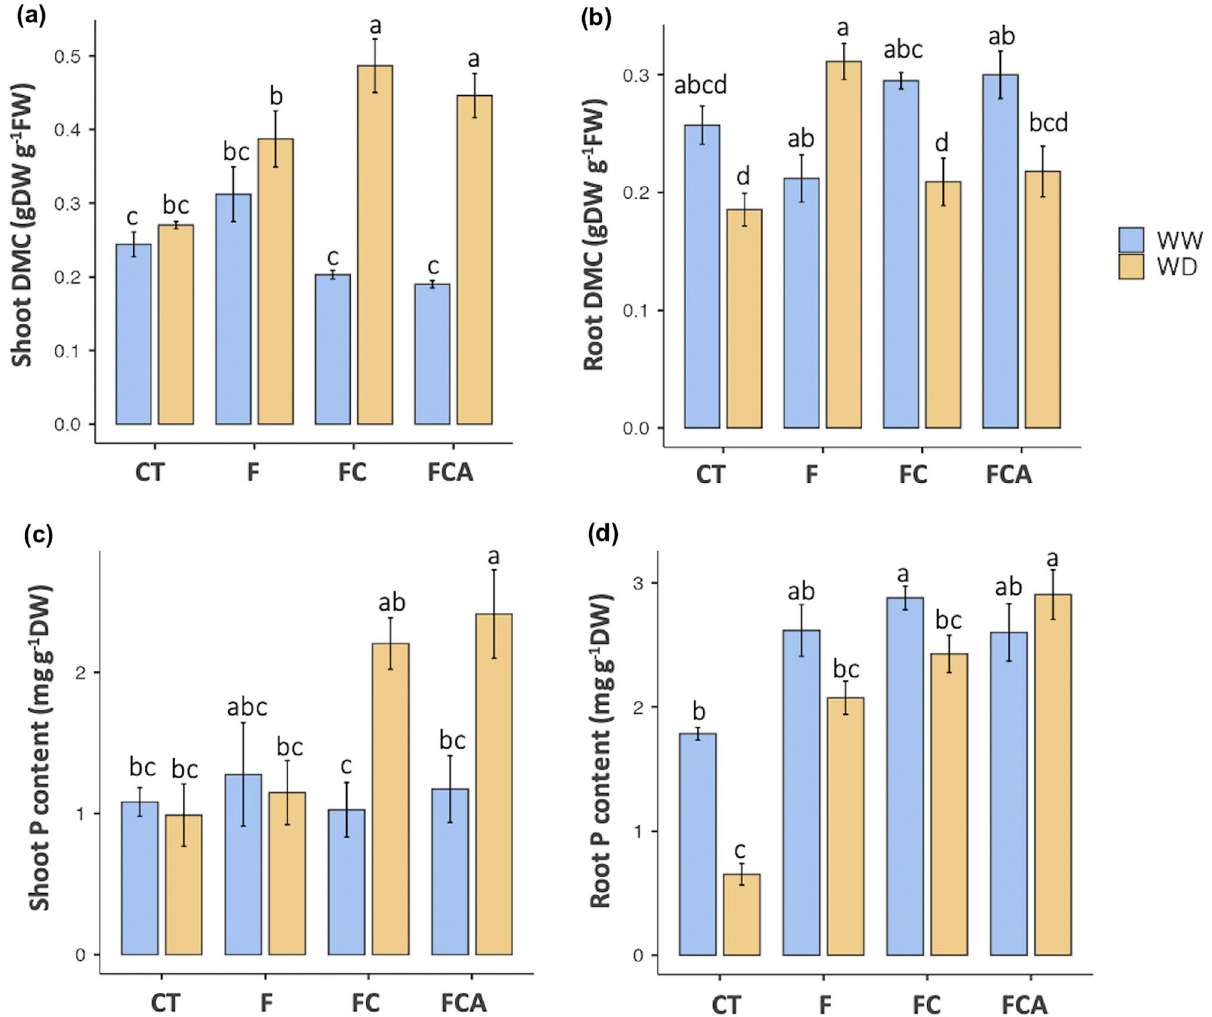
Figure 3. Dry matter content (DMC) of shoot and root ( a and b ) and phosphorus content in the shoot and root ( c and d ) in cv. Leum Pua inoculated with and without AMFs (F, FC, FCA, and CT) on the 21st day of well-watered and water deficit conditions. Statistical data access with a minimum of n = 4 and mean ± standard deviation. Different letters along plots represent significant difference at p =